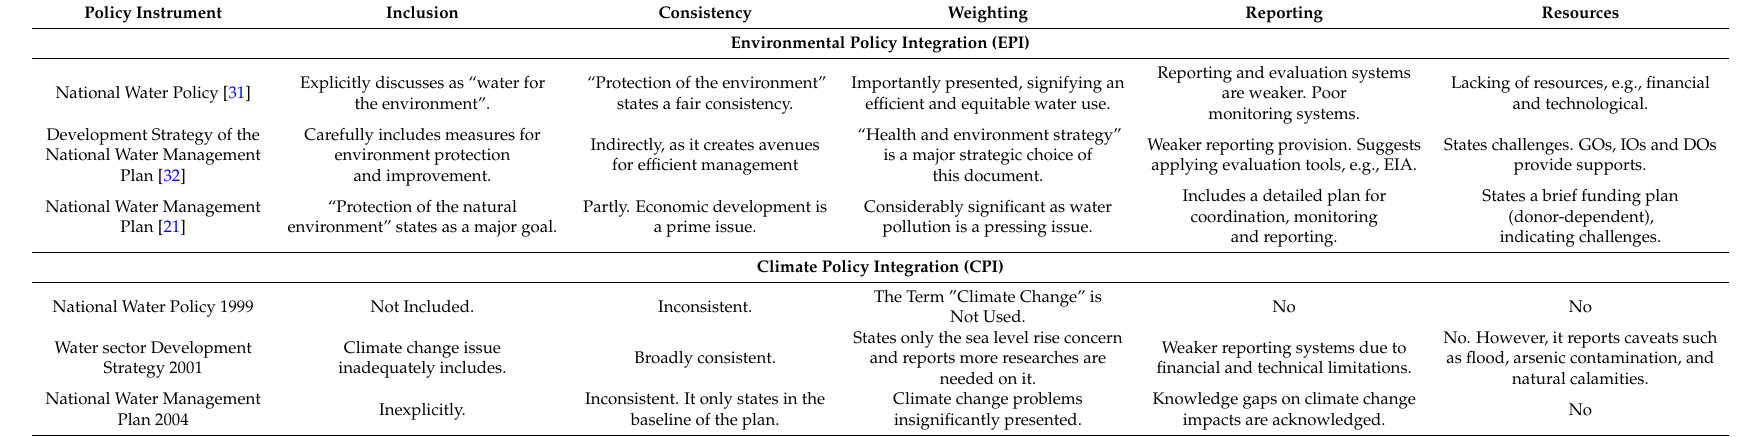
Table 2. Environmental and climate policy integration of major national policies of